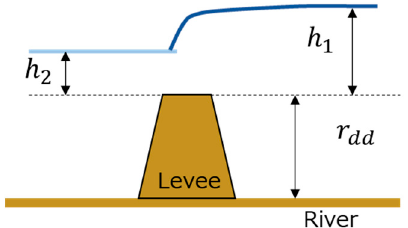
Figure 7. The conceptual diagram for deriving the levee breach degree.